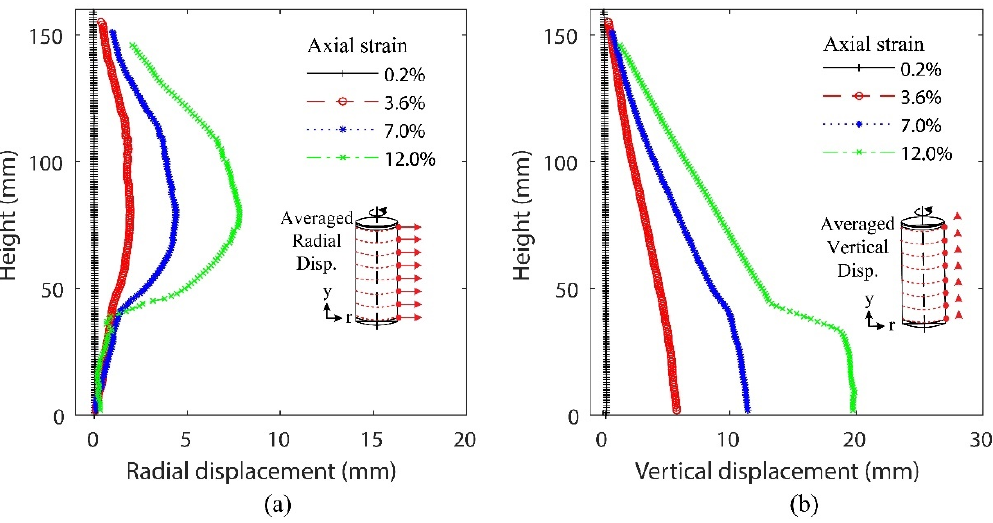
Figure 18. Vertical profiles of averaged displacements along the axial direction of test 120904c: radial displacements ( a ) and vertical displacements ( b ).